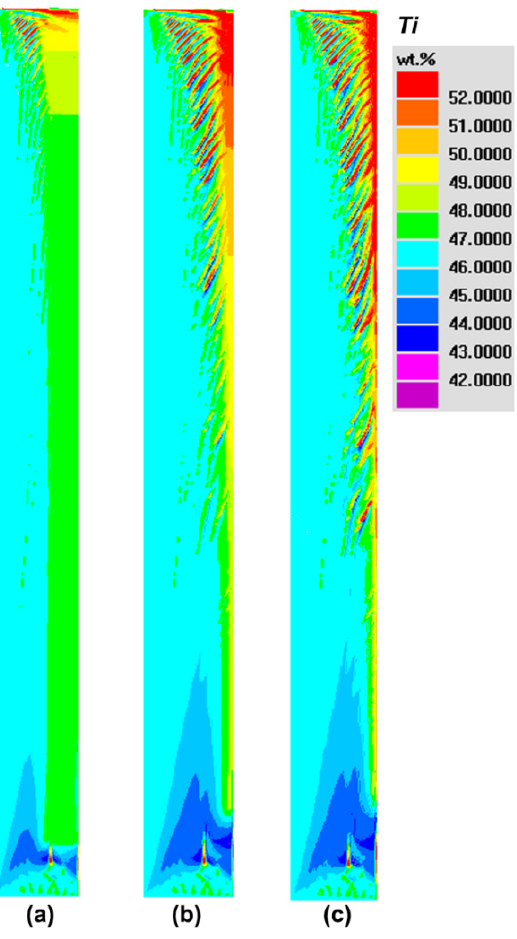
Figure 8. The macrosegregation distribution and evolution of Ti in the NbTi ingot. ( a ) 1000 s; ( b ) 2700 s; ( c ) 11,000 s. At 2700 s, a solidification front arrives appropriately at the half of the ingot. At 11000s, the solidification of the ingot is complete.